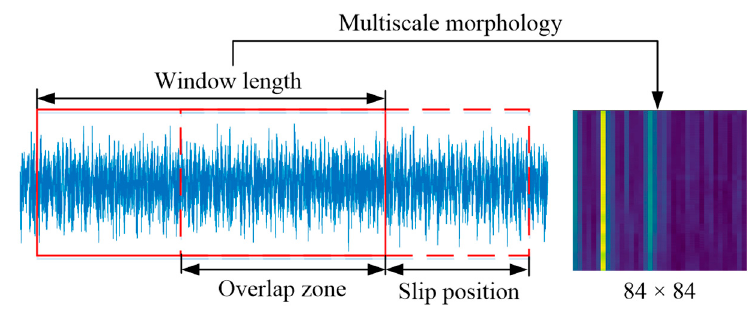
Figure 4. Result of converting the signal into